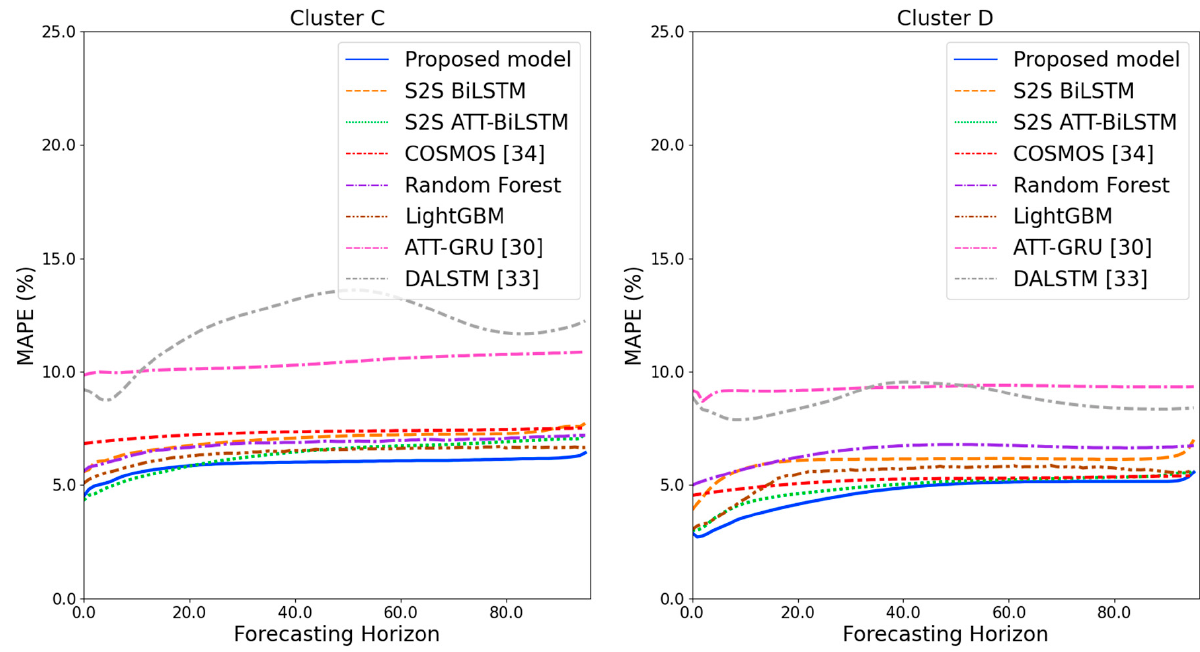
Figure 11. MAPE results of clusters A and B over the entire forecasting horizon in (%).